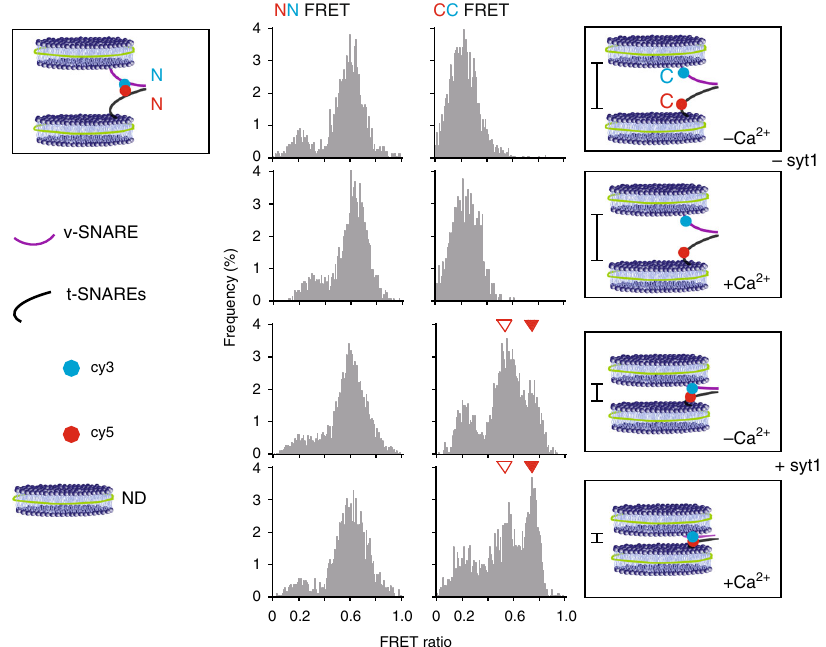
Fig. 4 smFRET reveals the impact of syt1 on trans -SNARE complex assembly. smFRET histograms of trans -SNARE complexes, under the conditions indicated on the far right, using FRET pairs (cy3, shown as blue dots and cy5, shown as red dots) near the N- (NN; left panels) or the C-termini (CC; right panels) of the SNARE motifs of syb2 and syntaxin-1A, respectively. For clarity, the t-SNARE heterodimer is presented by a single black line, and because NN smFRET was not affected by Ca 2 + or syt1, only the starting condition is illustrated for the NN experiments (upper left). In the illustrations on the right ( + / − Ca 2 + and syt1), vertical lines indicate the relative distance between v- and t-SNARE NDs under each condition. NN: n = 67 ( − Ca 2 + , − syt1), 61 ( + Ca 2 + , − syt1), 83 ( − Ca 2 + , + syt1), 64 ( + Ca 2 + , + syt1). CC: n = 79 ( − Ca 2 + , − syt1), 69 ( + Ca 2 + , − syt1), 74 ( − Ca 2 + , + syt1), 87 ( + Ca 2 + , + syt1). ND1 in all experiments. Data were collected using three independent sets of NDs. In all smFRET experiments, − Ca 2 + samples contained 1 mM EGTA; + Ca 2 + samples contained 500 µ M [Ca 2 + ] free